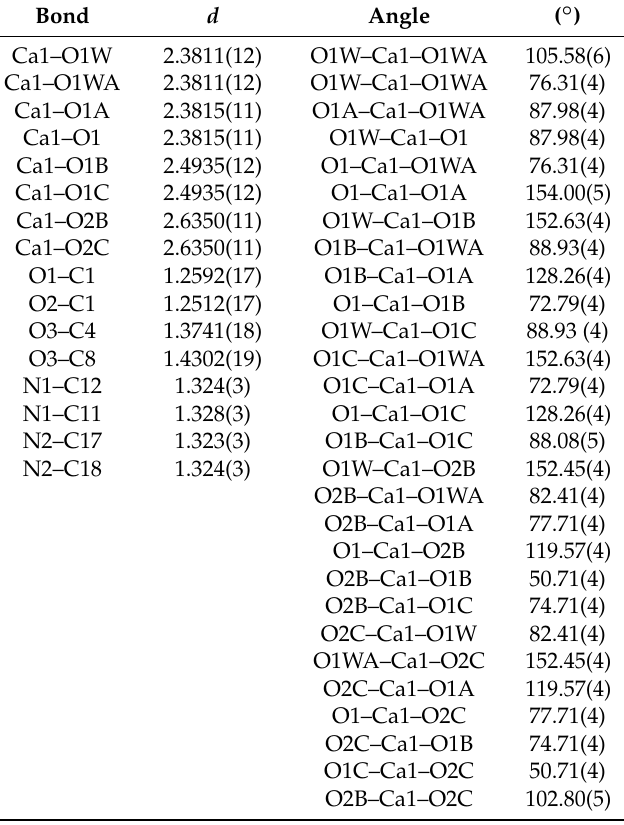
Table 1. Selected bond lengths d (Å) and bond angles ( ° ) for [CaL 2 (H 2 O) 2 ] n . Bond